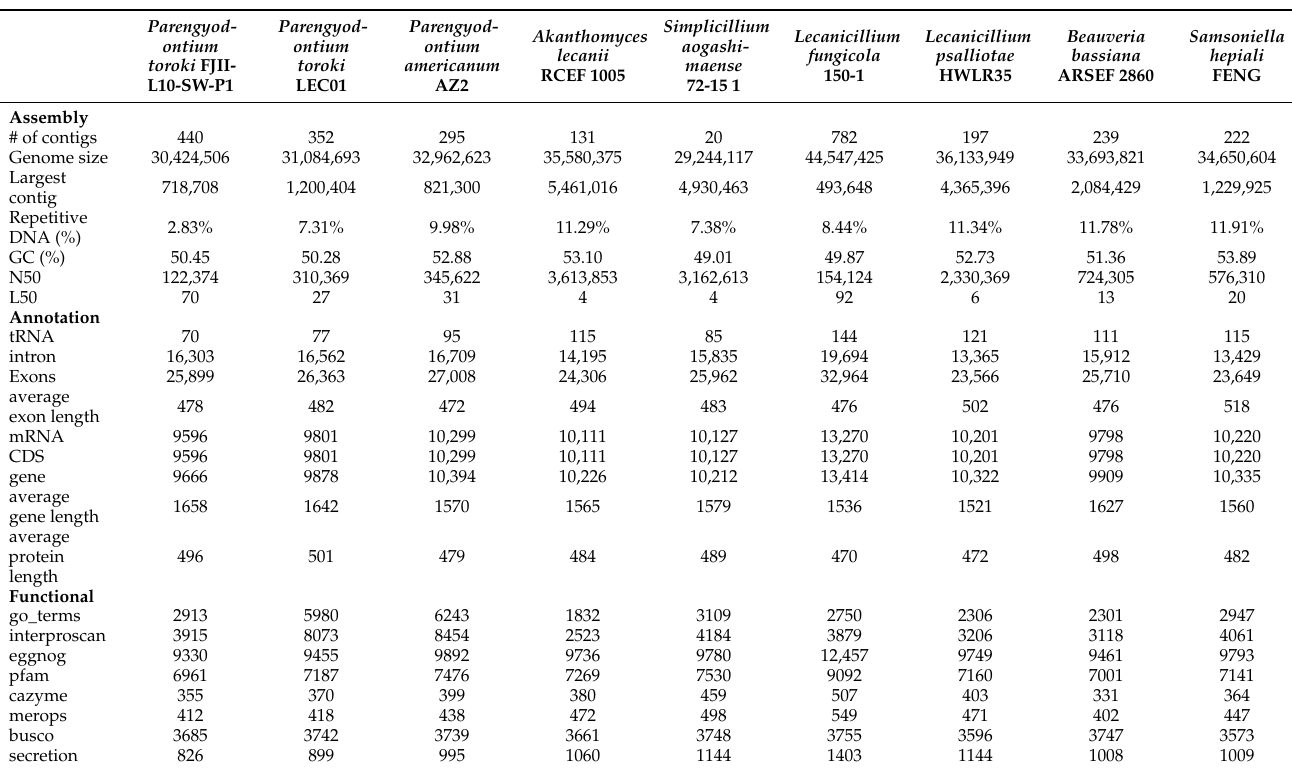
Table 1. Summary of the draft whole-genome sequences of Parengyodontium and closely related species belonging to the family